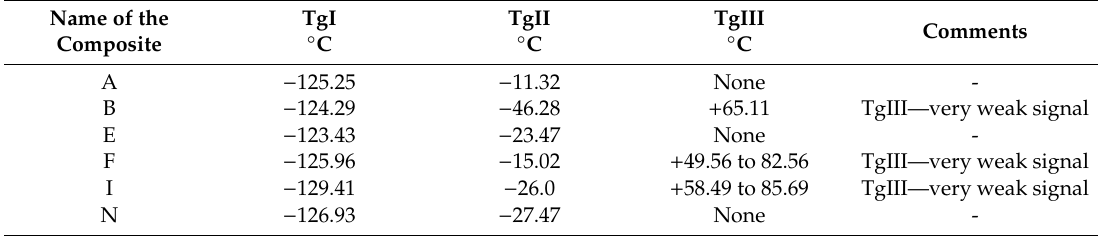
Table 4. Results of Tg determinations obtained for PSUR-based UV-cured composites containing non-reactive ILs. Composites prepared without IL (A) and without any solvent and lithium salt (N) were included for